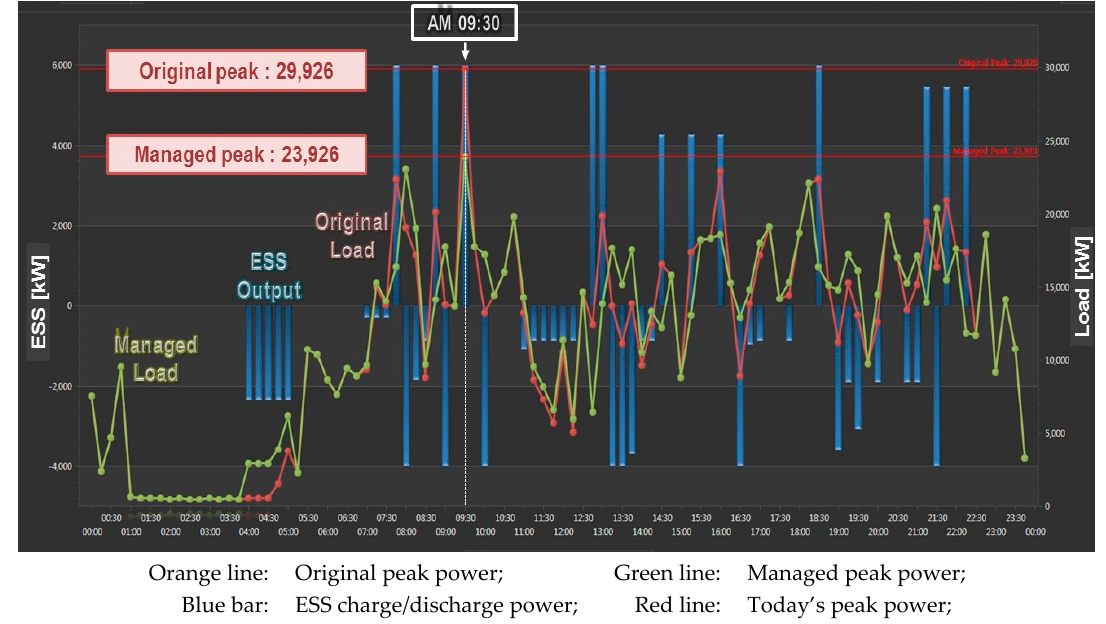
Figure 3. Simulation results of the daily operation of the peak power reduction system.